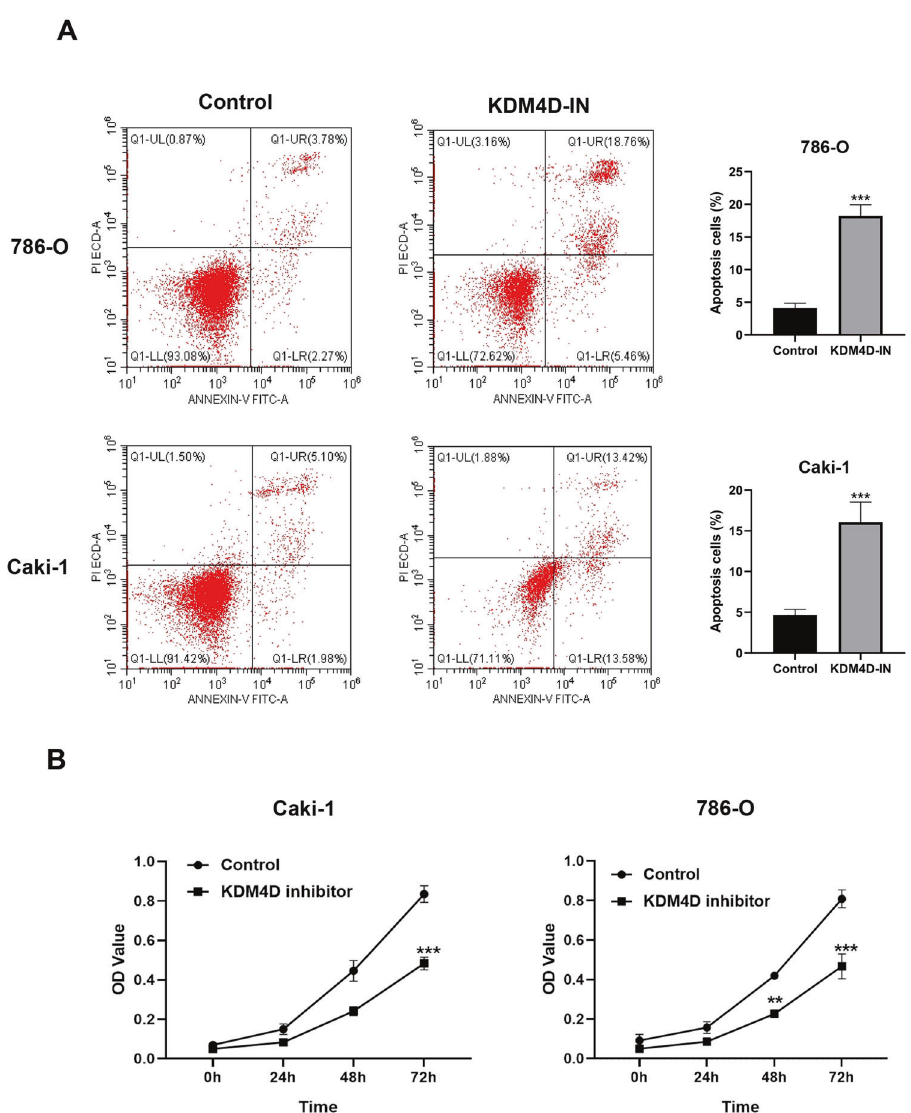
Fig. 3 KDM4D inhibition suppress the proliferation of ccRCC cells and promote apoptosis. A Cell apoptosis assays demonstrate that KDM4D inhibition reduces tumor cell apoptosis. B The CCK8 assays showed that the proliferation of renal cancer cells was signi fi cantly inhibited by KDM4D inhibitor. ** p < 0.05, *** p <